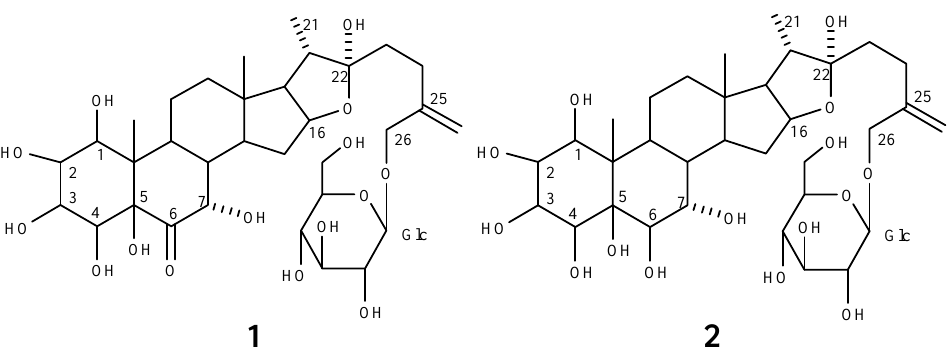
Figure 1 . Structures of compounds 1 and 2